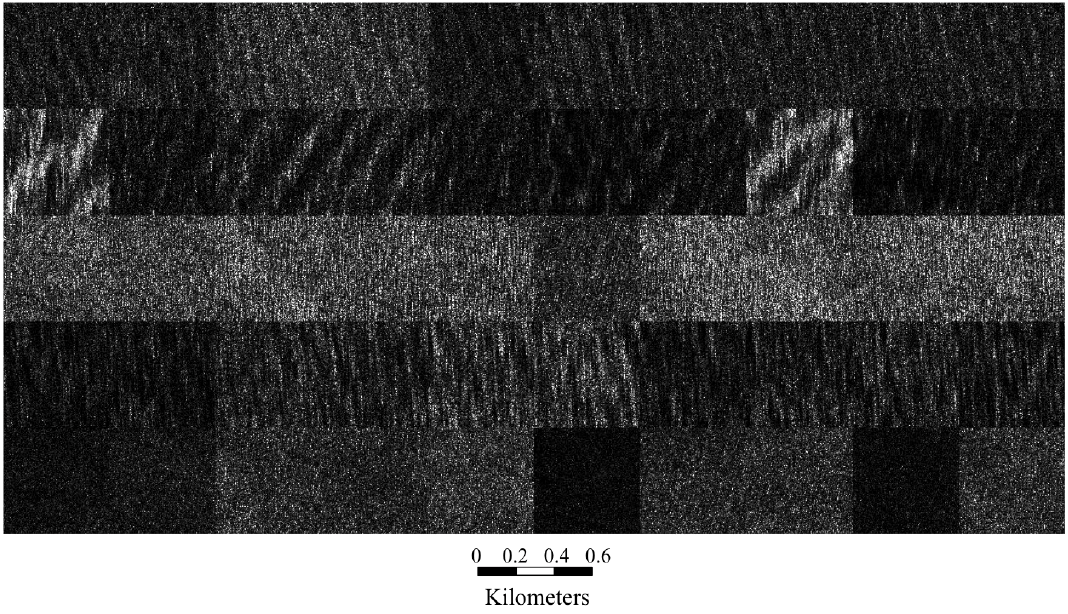
Figure 4. Examples of 500 × 500-pixel patches of each class. The five rows correspond to the five classes defined in Section 3, presented in ascending order. Each row contains 10 patches of the same